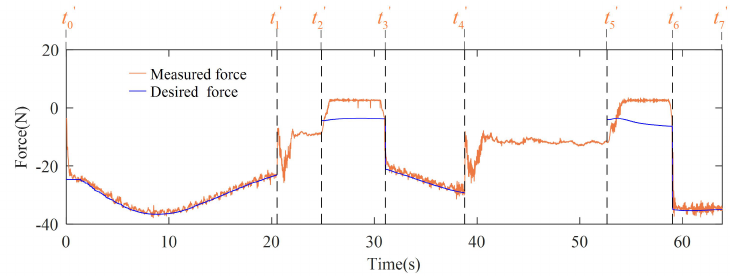
Figure 17. Experiment force under under motion modeled by DMP and